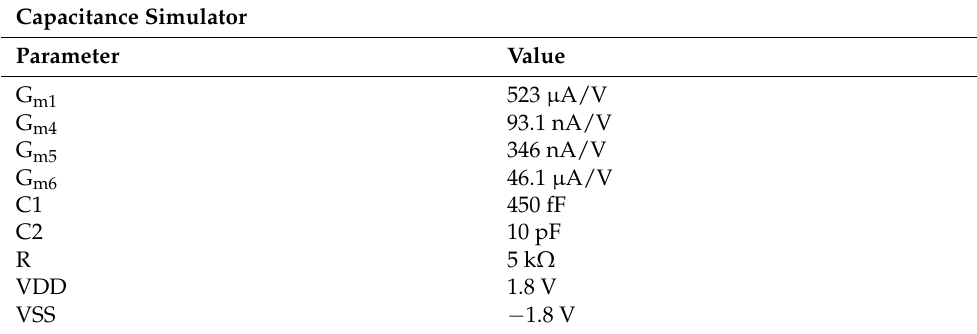
Table 12. Narrow bandpass filter